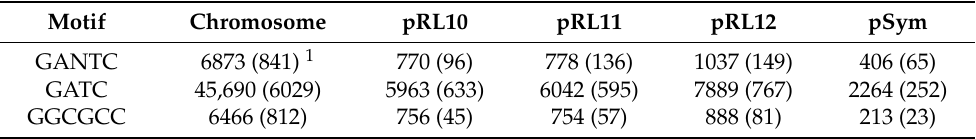
Table 3. Methylation patterns intersection with genes and gene promoter